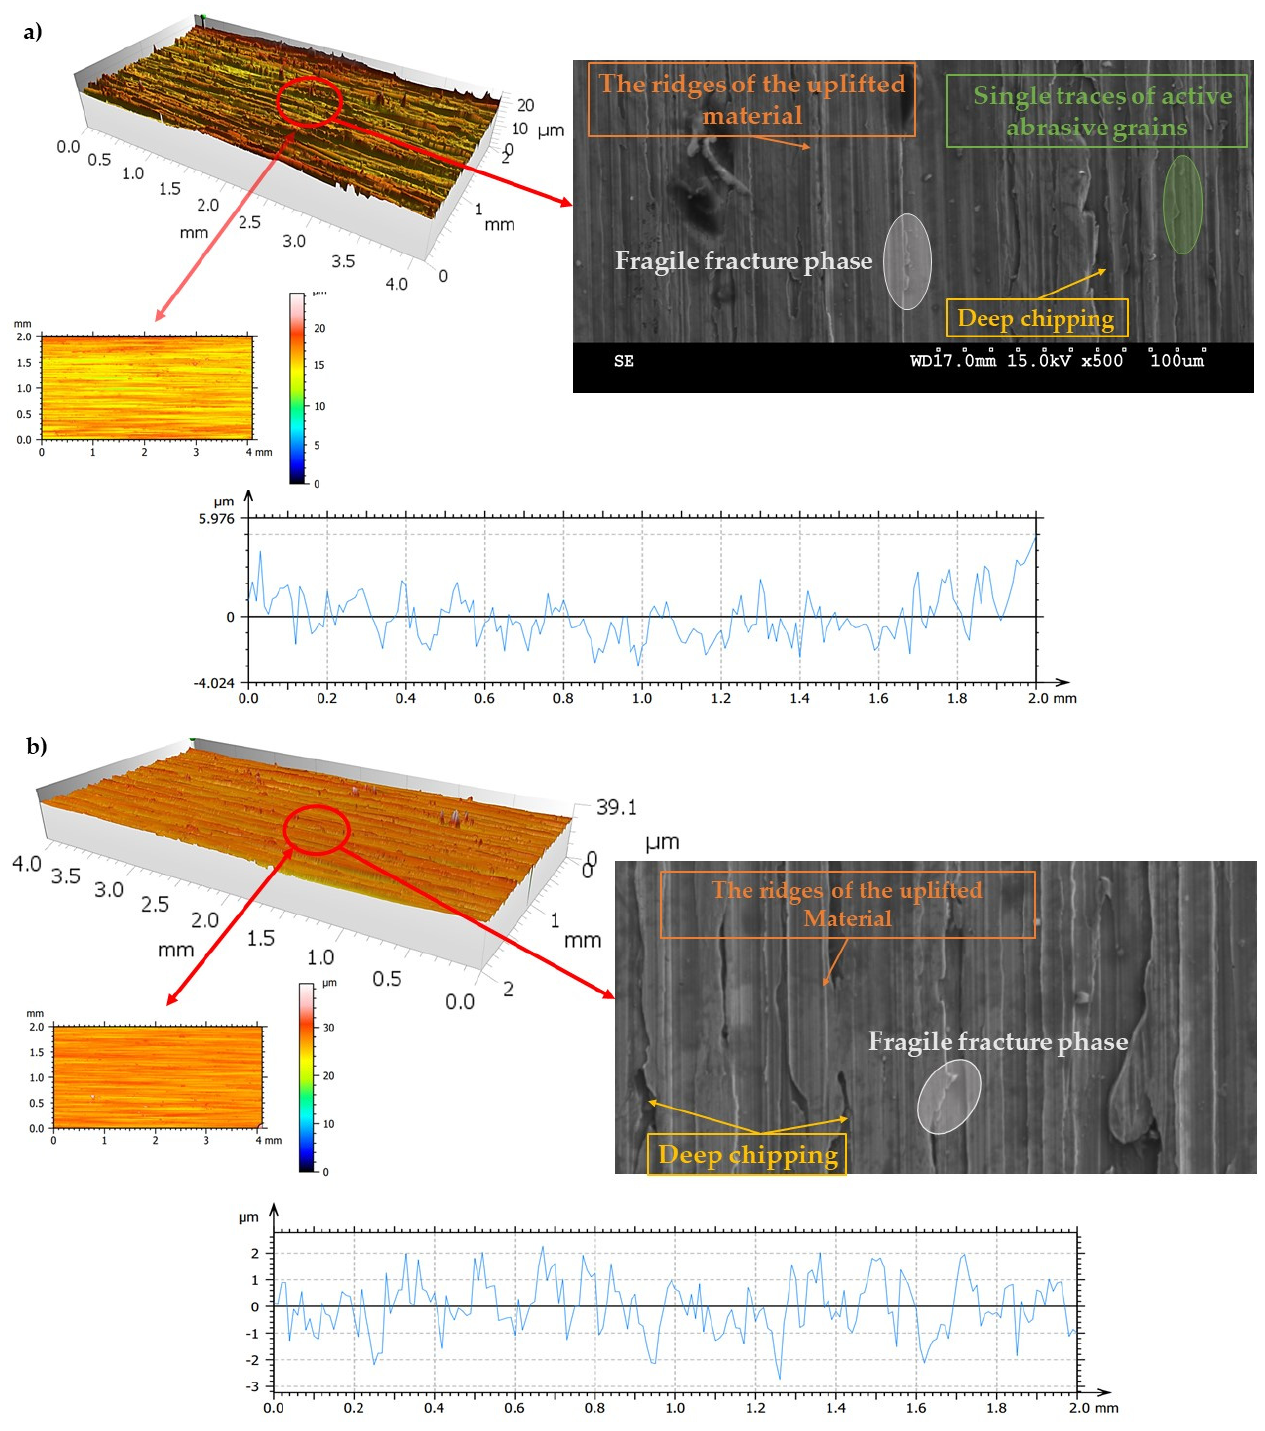
Figure 4. Surface texture of the specimen after machining with ( a ) a multigranular wheel and ( b ) a grinding wheel. Vc = 33 m/s, Vp = 133 mm/min and Vw = 13900 mm/min.